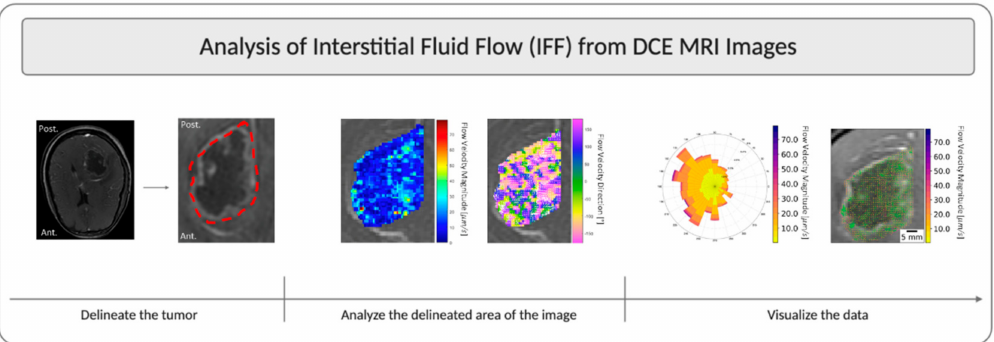
Figure 1. Overview schematic of IFF analysis using DCE-MRI. This figure illustrates the steps for analysis using patient W13 from the Ivy Glioblastoma Atlas Project (GAP) database as an example. The tumor was located on a slice of interest, all timepoints of the slice of interest were extracted from all DCE acquisitions, and then the tumor was delineated and analyzed using the Lymph4D analysis tool. The component-wise velocity vectors from the analysis were then input into other MATLAB R2020a and Python 3.6 scripts to develop images overlayed with a streamline and a quiver plot, as well as the rose plots of velocity magnitude and